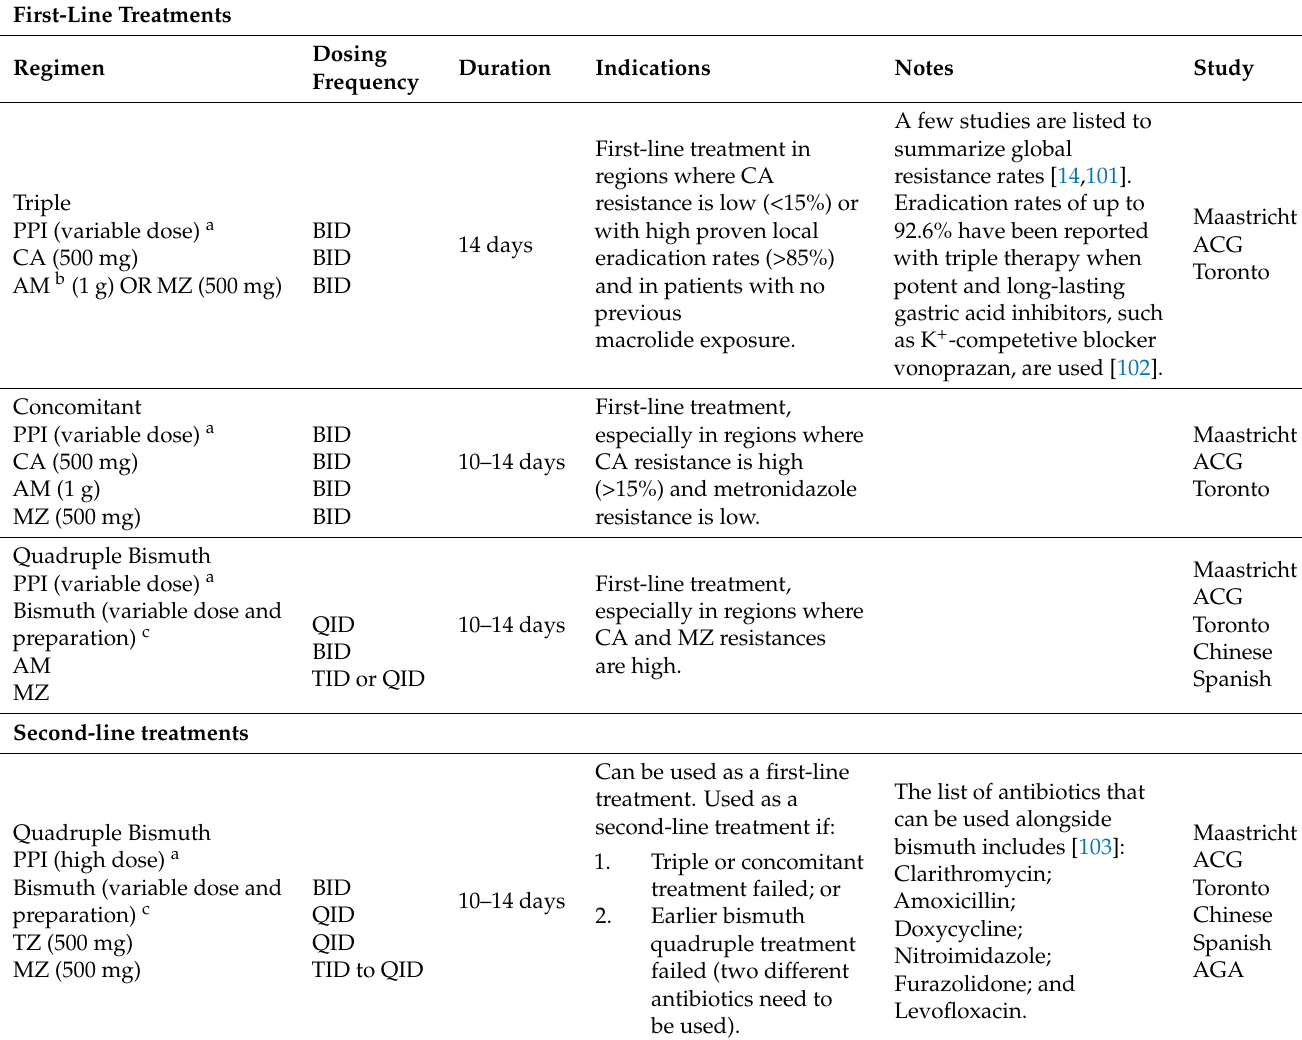
Table 2. Treatment options for Hp